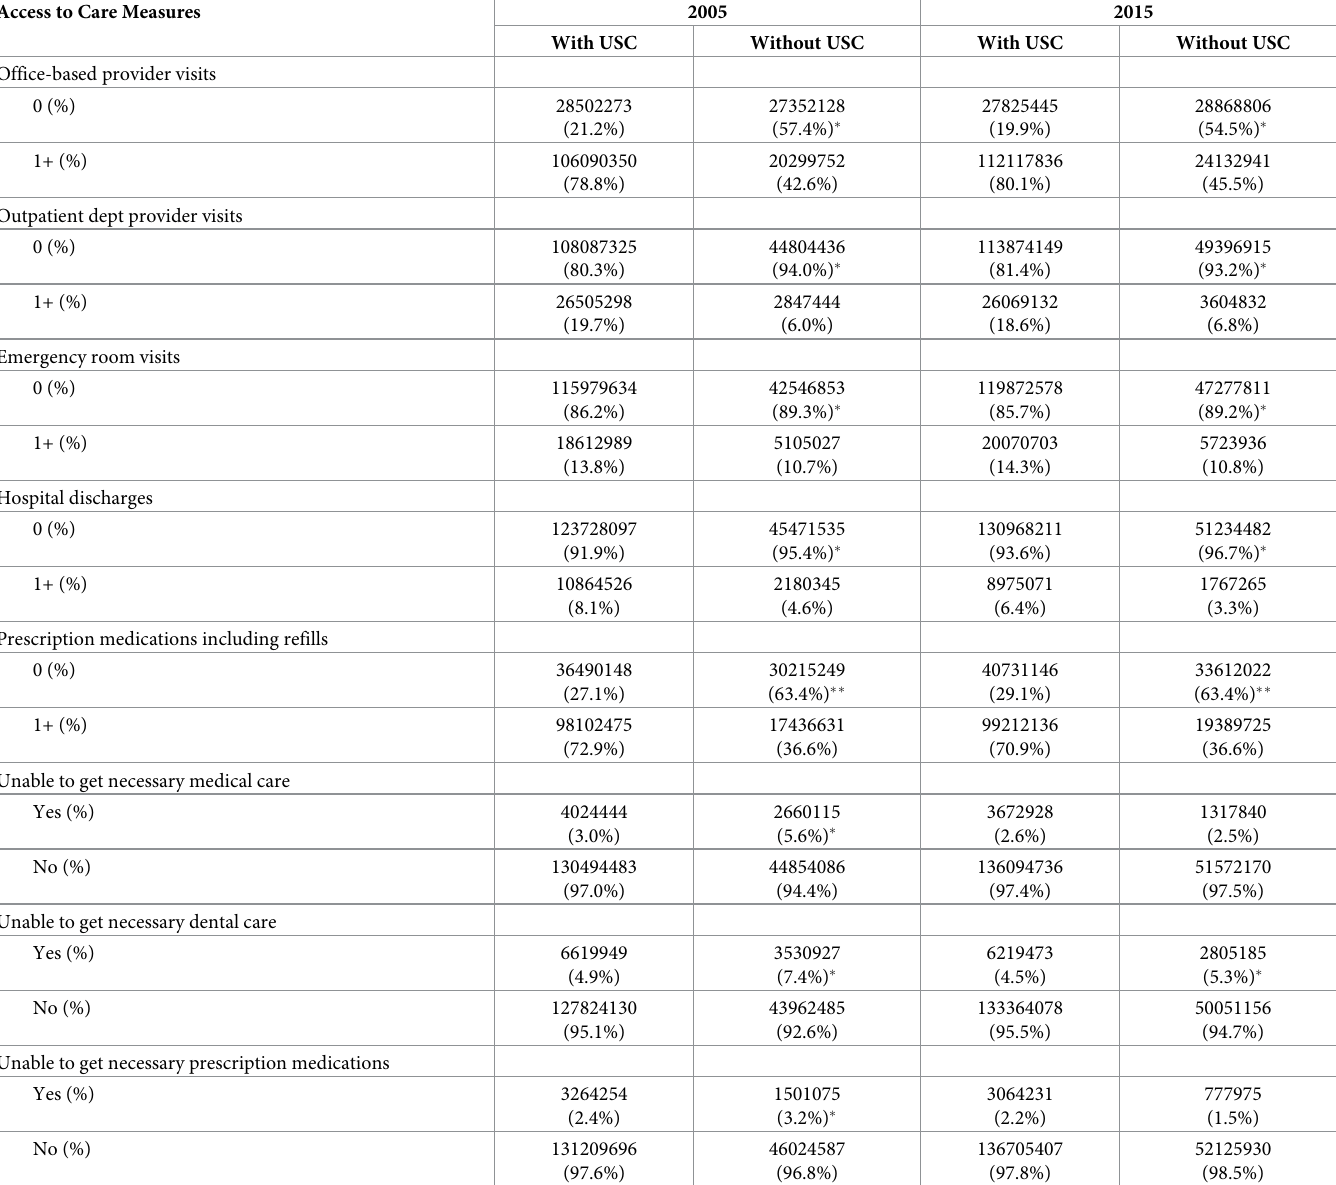
Table 3. Association between Usual Source of Care (USC) and access to care: 2005 vs.